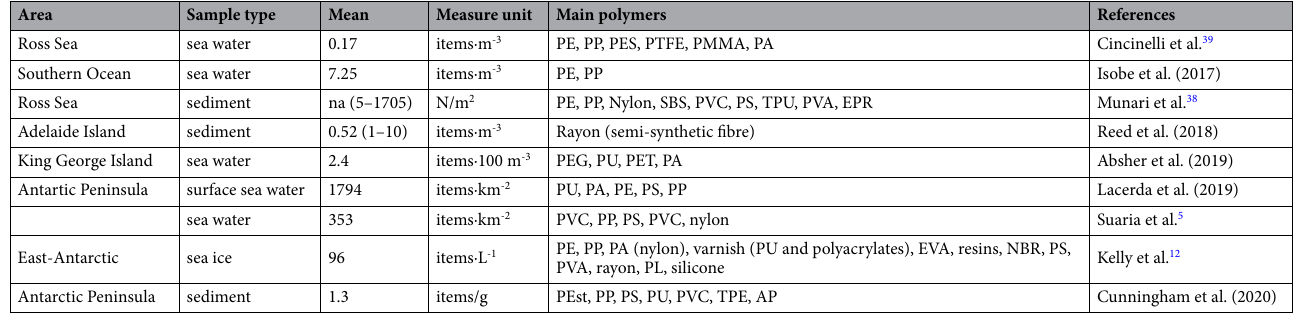
Table 1. Summary of anthropogenic microparticles in Antarctic seawater and sediment (below the sixtieth parallel). Polyethylene: PE; polypropylene: PP; polystyrene: PS; polyvinyl chloride: PVC; nitrile rubber: NBR; poly-methyl methacrylate: PMMA; poly vinyl alcohol: PVA; ethylene vinyl acetate: EVA; polyethylene glycol: PEG; polyurethane: PU; polyethylene terephthalate: PET; polyamide: PA; polyester: PES;